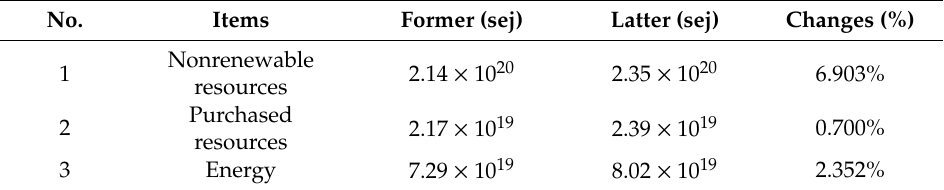
Table 13. The sensitivity changes in three main contributors of the evaluated system.